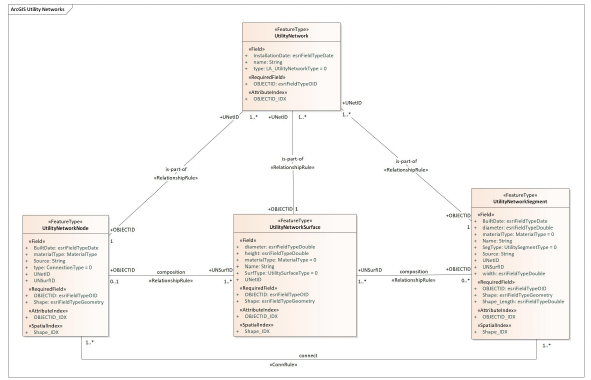
Figure 6. The logical data model of utility networks.